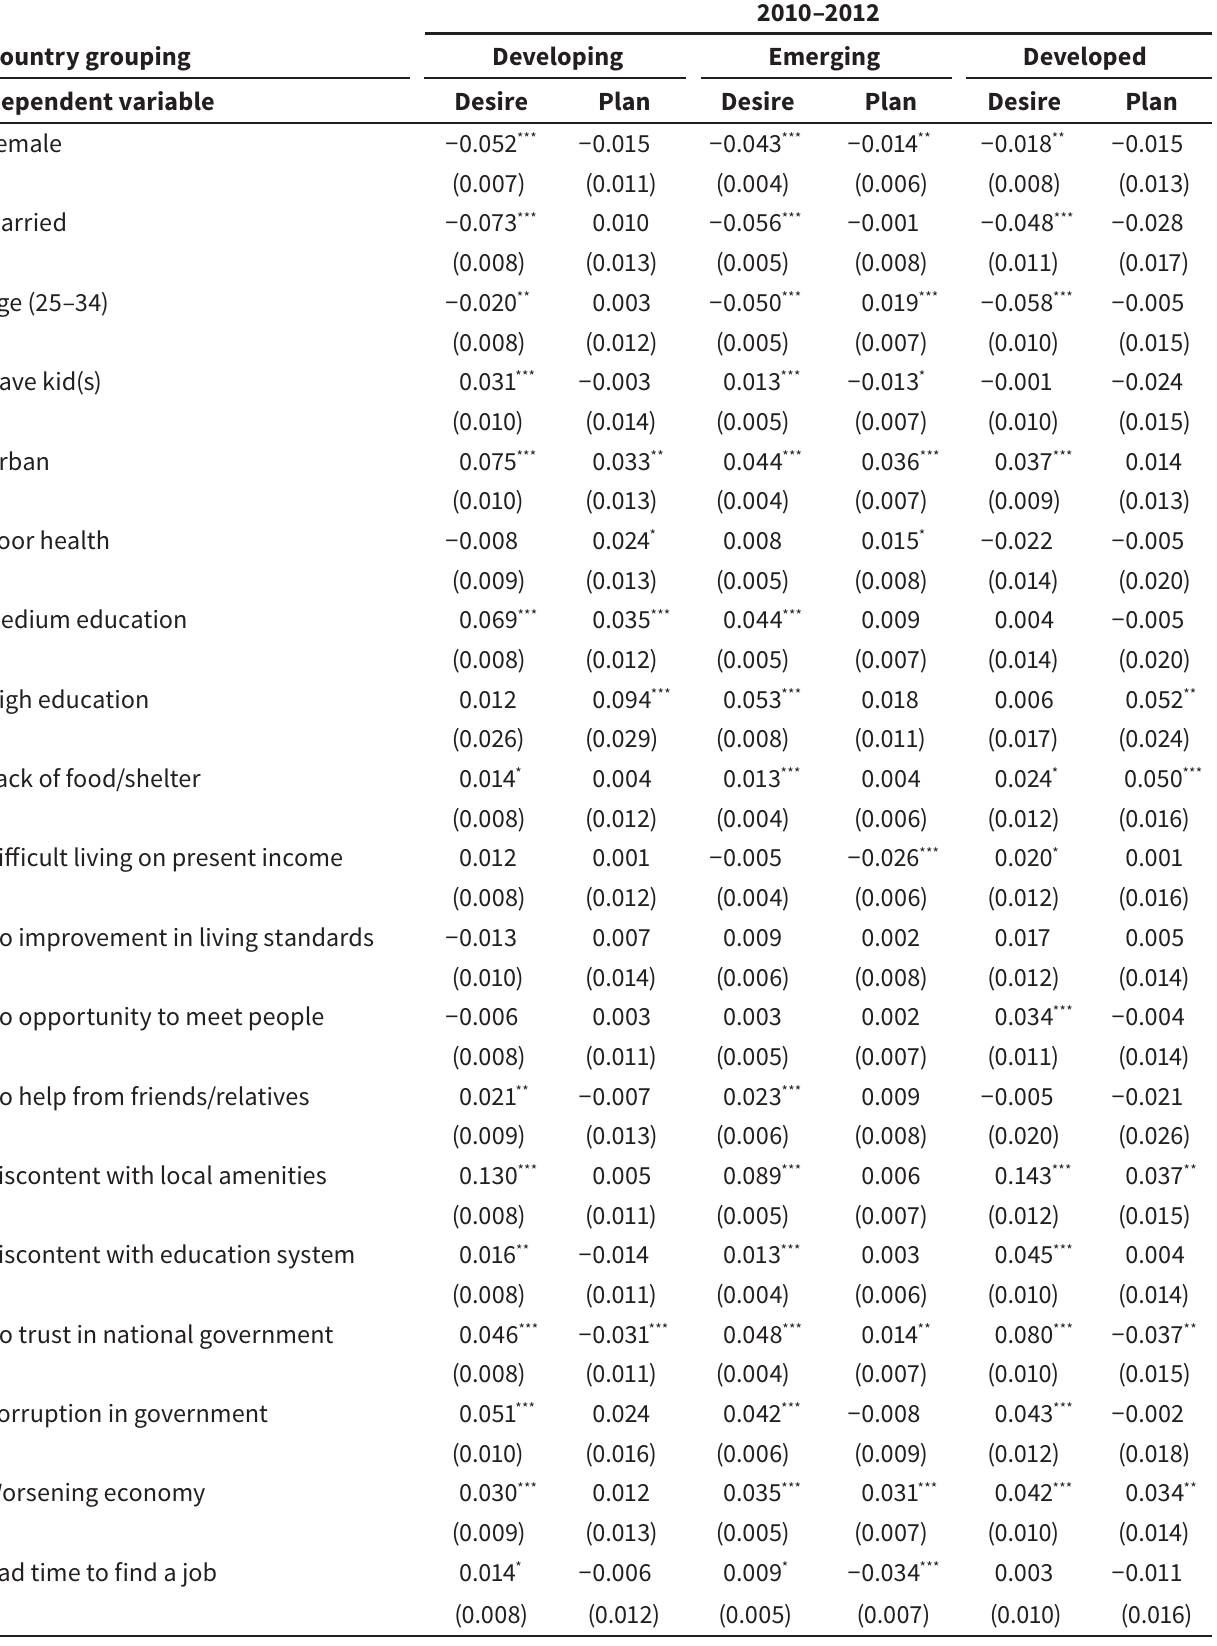
Youth (15–34) desire/plan to migrate abroad, 2010–2012, full results corresponding to Panel A of Table